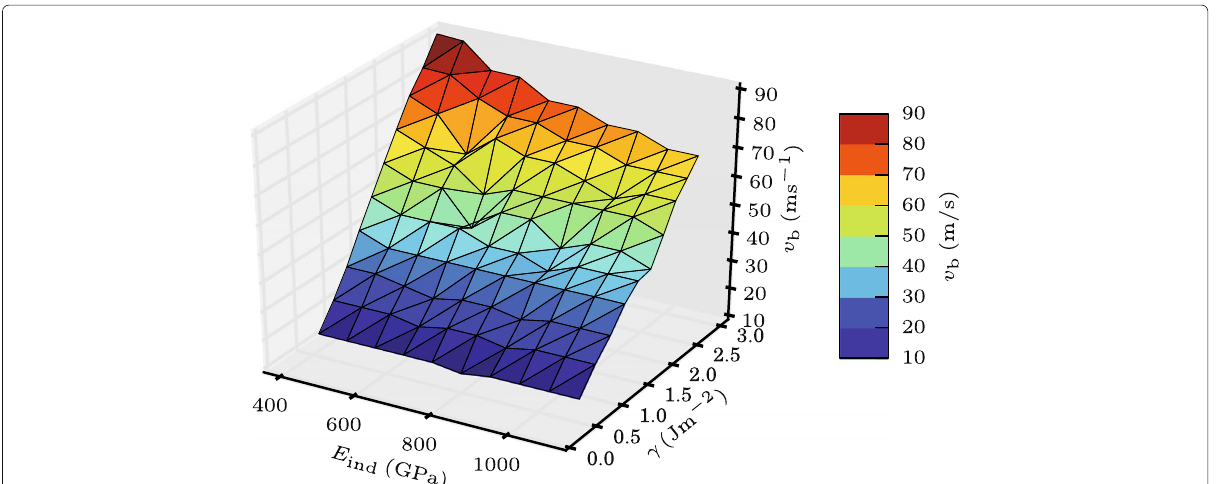
Fig. 3 Bouncing velocity. Three-dimensional plot of the dependence of the bouncing velocity v b on the indentation modulus E ind and the surface energy